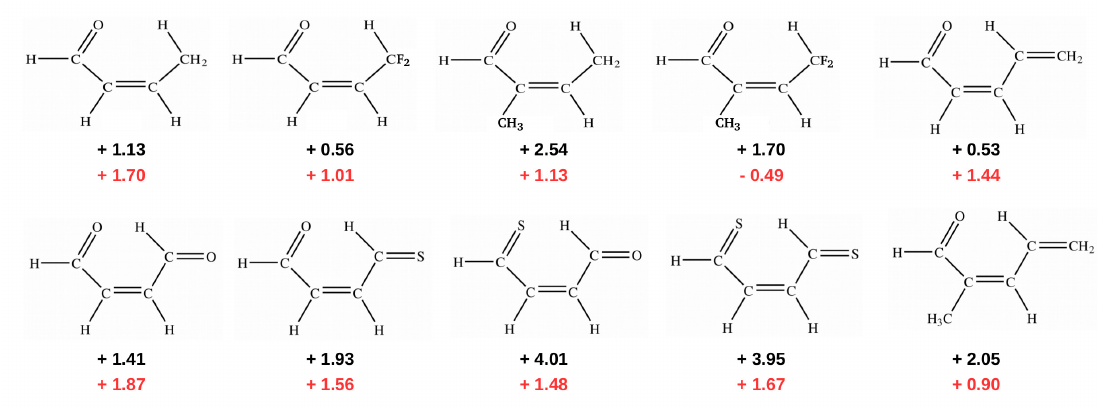
Figure 12. Energy values (in kcal/mol) of intramolecular C-H · · · O/S interactions obtained [41] (B3LYP/aug-cc-pVTZ) by either OCM ( black ) or GCM ( red ).